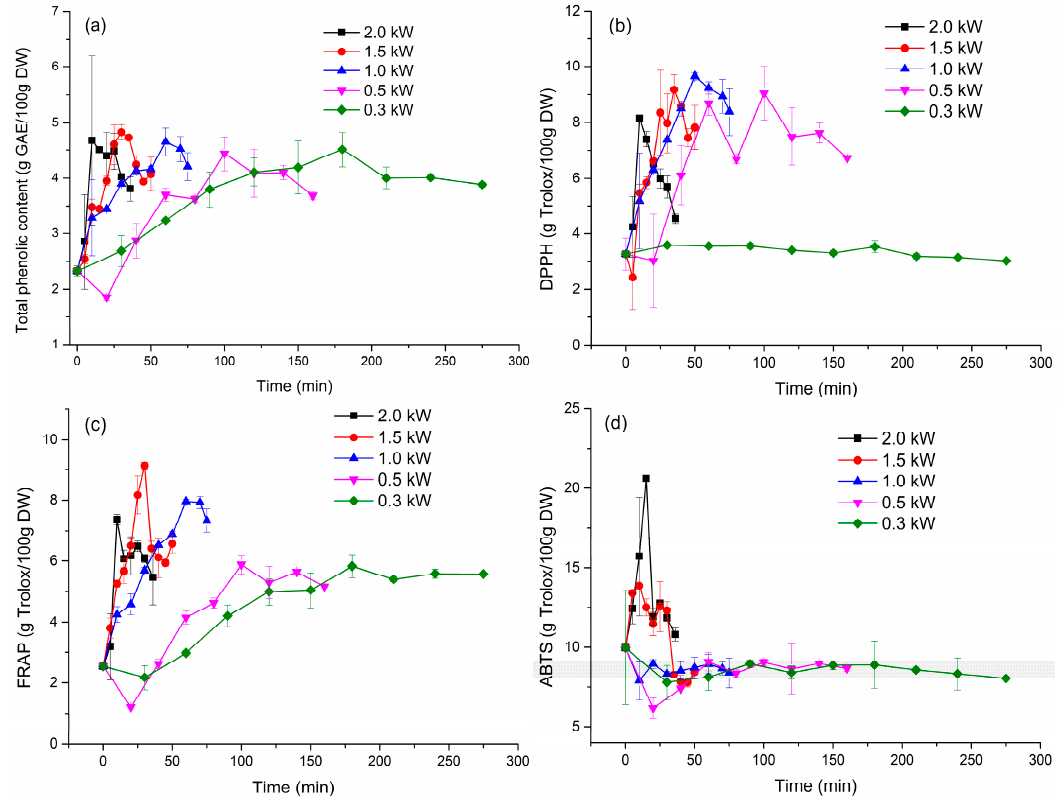
Figure 5. Kinetics of total phenolic content and antioxidant activity of coffee beans during MVD: ( a ) TPC; ( b ) DPPH; ( c ) FRAP; and ( d ) ABTS.